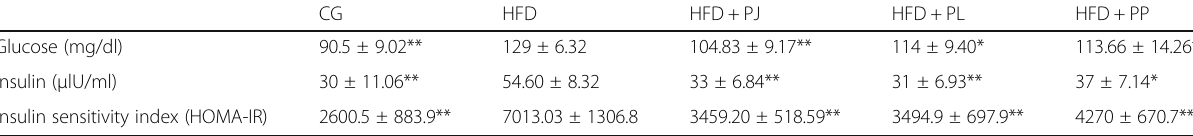
Table 2 Effect of HFD and pomegranate extracts administration plasma glucose, insulin levels and index (HOMA-IR)